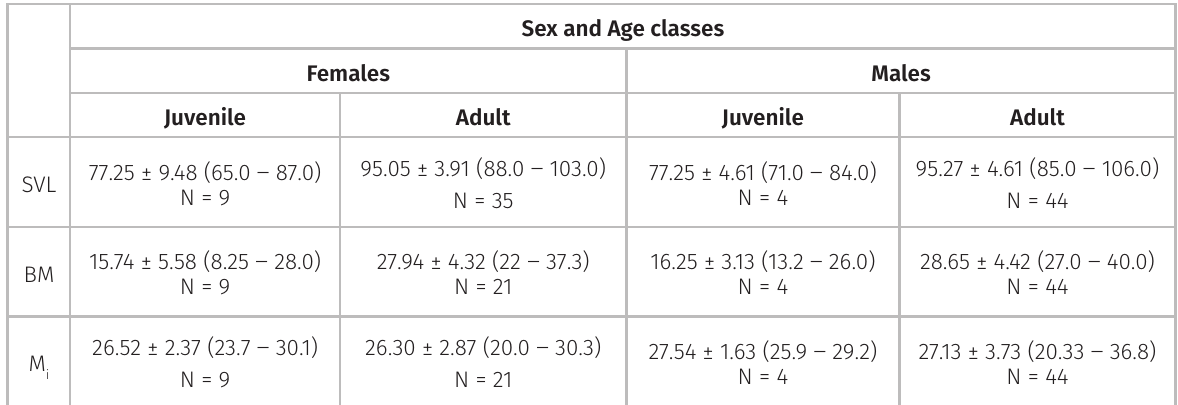
Table I. Body size variables and body condition of Phymaturus extrilidus by sex and age classes. Mean ± standard deviation, range between parenthesis, and sample size of snout-vent length (SVL, mm), body mass (BM, g), and body condition index (scaled mass index), in BM and of pregnant females are not